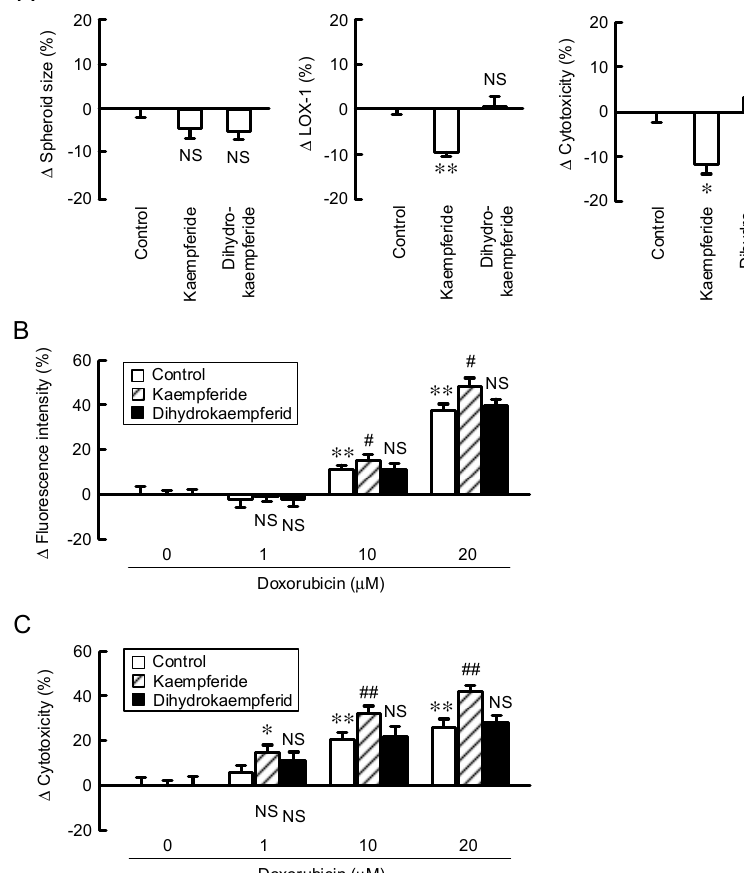
Figure 9. Increase in the sensitivity of spheroid cells to doxorubicin by kaempferide. ( A ) The spheroids were incubated in the absence (control) and presence of 10 µ M kaempferide or 10 µ M dihydrokaempferide for 24 h. Spheroid size, fluorescence intensity of LOX-1, and cell viability are represented as a percentage relative to the control. ** p < 0.01, * p < 0.05, and NS p > 0.05 compared with the control (one-way analysis). Spheroid size (F 2,16 = 1.71, p = 0.21639), LOX-1 (F 2,11 = 8.31, p = 0.00902), and cytotoxicity (F 2,10 = 6.28, p = 0.02293). ( B ) The spheroids were pre-incubated with 10 µ M kaempferide or 10 µ M dihydrokaempferide for 24 h, followed by incubation with doxorubicin for 60 min. The fluorescence intensity of doxorubicin in the spheroids was examined using a BZ-X800 fluorescence microscopy. ( C ) After incubation of the spheroids with doxorubicin in the absence and presence of 10 µ M kaempferide or 10 µ M dihydrokaempferide for 24 h, cell viability was measured using a CellTiter-Glo 3D Cell Viability Assay kit. The fluorescence intensity of doxorubicin and cell viability are represented as a percentage relative to 0 µ M doxorubicin. n = 4–6. ** p < 0.01, * p < 0.05, and NS p > 0.05 compared with 0 µ M. ## p < 0.01 and # p < 0.05 compared with control (Two-way analysis). Fluorescence intensity (F 2,59 = 4.54, p = 0.01563) and cytotoxicity (F 2,35 = 9.27, p = 0.00212).